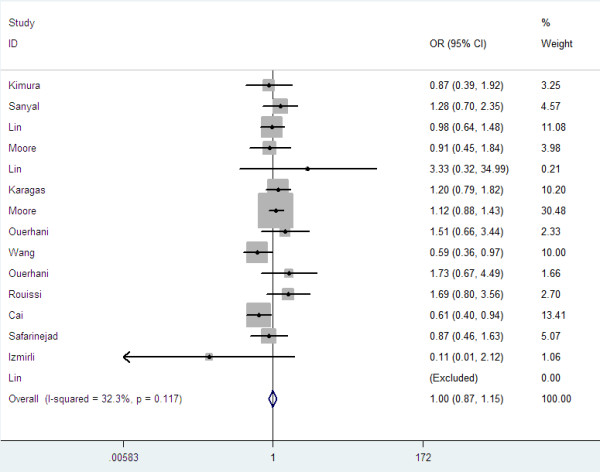
Forest plots for MTHFR Ala222Val polymorphism and risk of bladder cancer in overall populations (Dominant model).